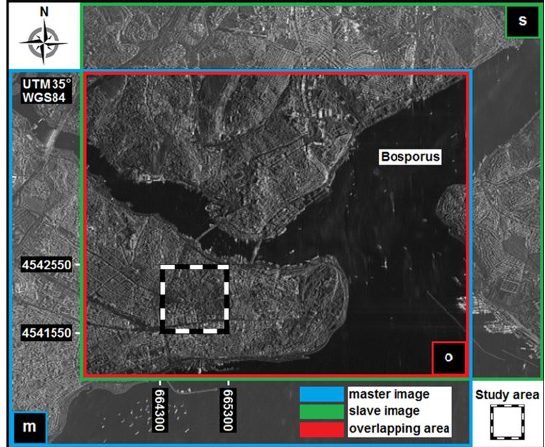
Figure 1. Study area and the distribution of terrain inclination (m= master CSK image; s= slave CSK image) The German TSX was launched in 2007 and has 11 days repeat- cycle. The CSK mission consists of four low earth orbit mid- sized X-band SAR satellites constellation that were launched in 2007 and 2008 by the Italian Space Agency and each satellite has 16 days repeat-cycle. For the selection of the most suitable master and slave images (InSAR-pairs), several parameters as overlapping area coverage, temporal baselines and start-stop